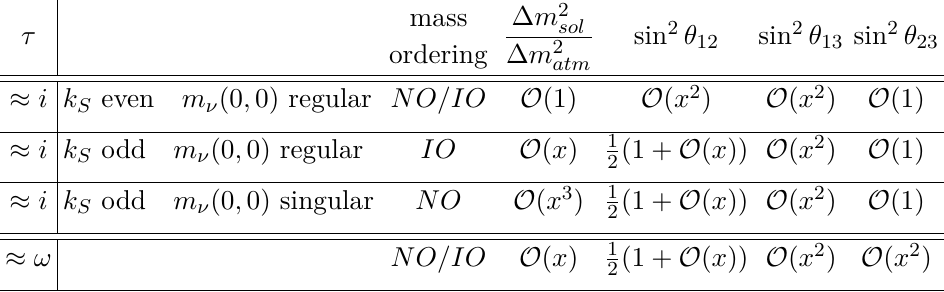
Table 5 . Synopsis of predictions in modular invariant flavor models of leptons, when the modulus τ falls in the vicinity of the fixed points τ = i or τ = ω and ρ l is an irreducible